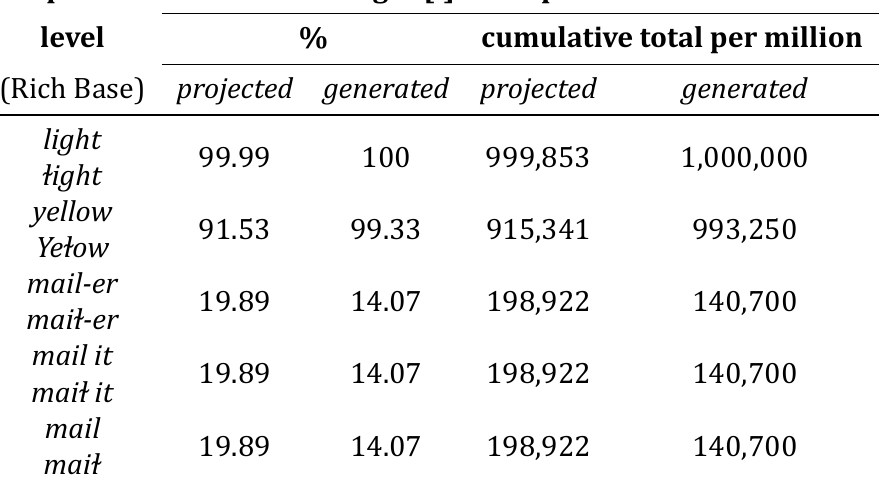
Table 11: Stem level